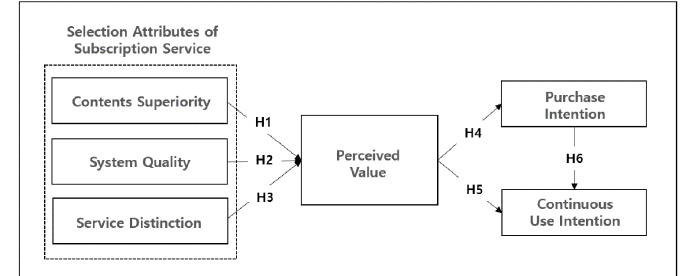
Figure 1. Research model.